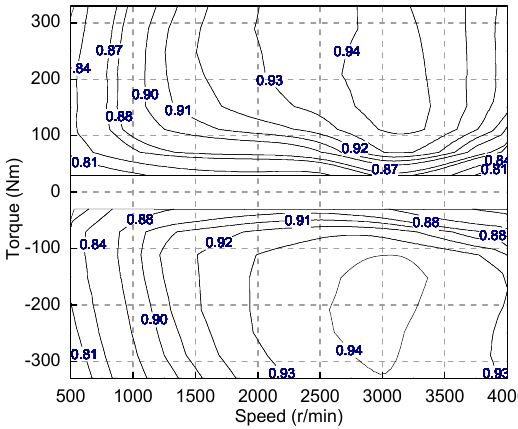
Figure 5. Generator efficiency map.